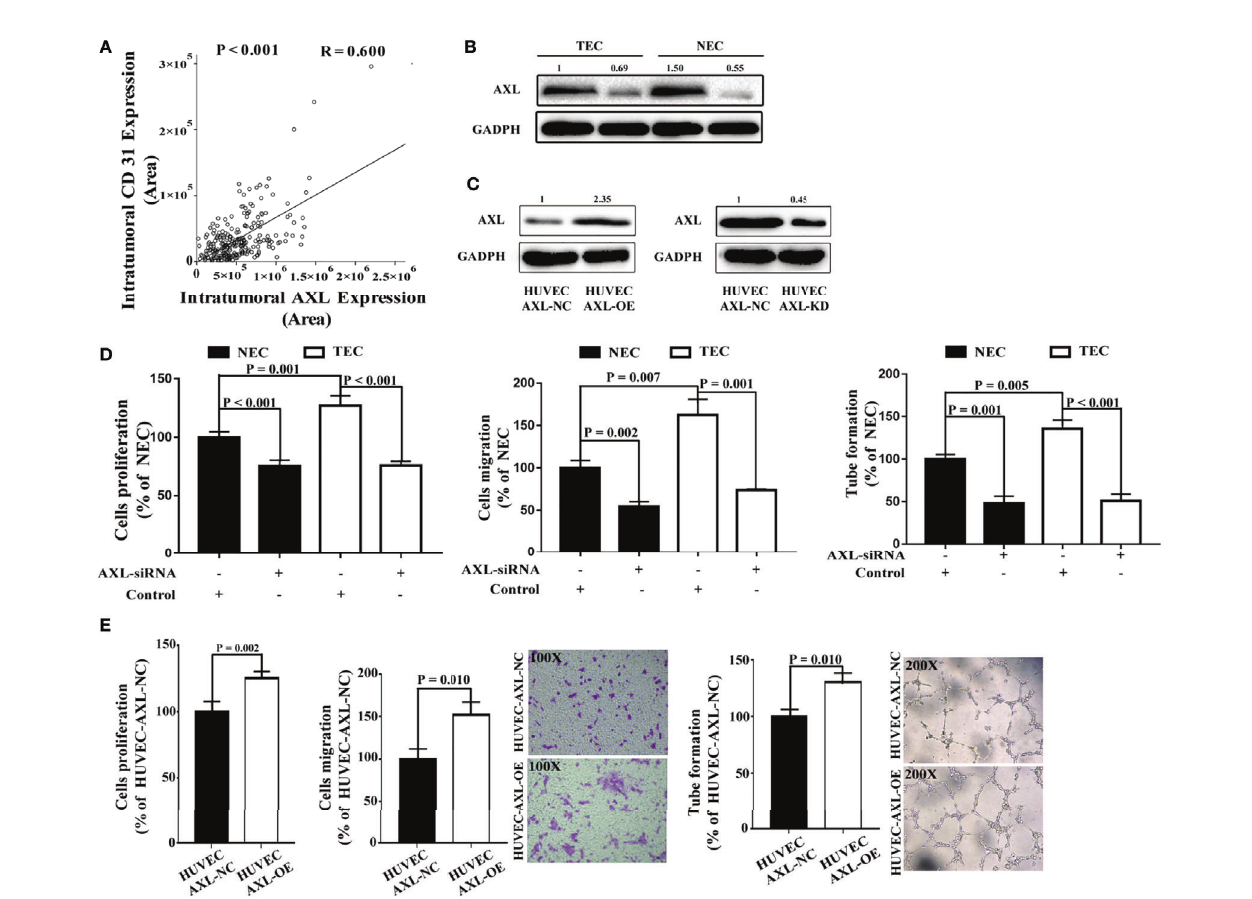
FIGURE 3 | AXL expression in ECs is involved in cell migration, proliferation, and tube formation. (A) Intratumoral AXL expression was positively correlated with CD31 expression (p < 0.001). (B) AXL expression was silenced by AXLsiRNA in both NECs and TECs, as measured by western blotting assay. (C) AXL overexpression was induced by AXL-overexpressing plasmid, both in NECs and TECs, as measured by western blotting assay. (D) AXL siRNA decreased the cell proliferation (p < 0.001), migration (NEC: p = 0.002; TEC: p = 0.001), and tube formation ability (NEC: p = 0.001; TEC: p < 0.001) of both NECs and TECs. (E) Overexpression of AXL in HUVECs increased the cell proliferation (p = 0.002), migration (p = 0.010), and tube formation (p = 0.010) ability of